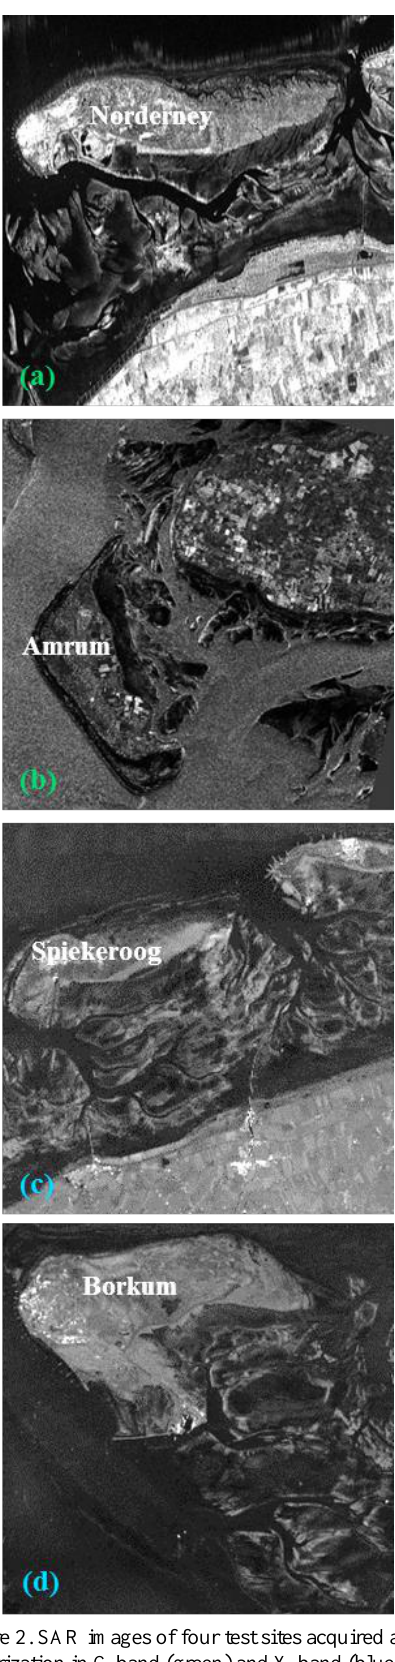
Figure 2. SAR images of four test sites acquired at VV polarization in C-band (green) and X-band (blue). (a) Norderney: Dec. 13, 17:29 UTC; (b) Amrum: Dec. 24, 05:43 UTC; (c) Spiekeroog: Feb. 06, 05:42 UTC; (d) Borkum: Mar. 08, 17:18